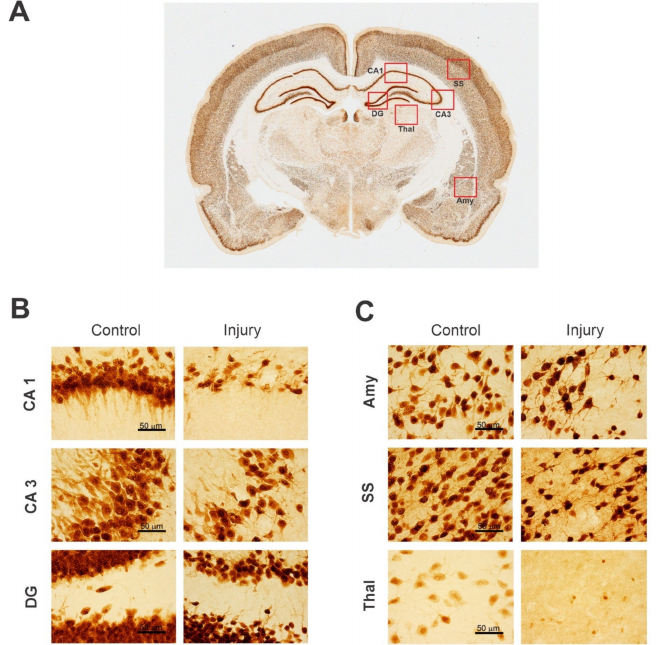
Figure 2. NeuN(+) immunostaining of principal neurons in the brain . Representative images of NeuN(+) principal neurons in the brain sections of DFP chemically injured epileptic rats. ( A )